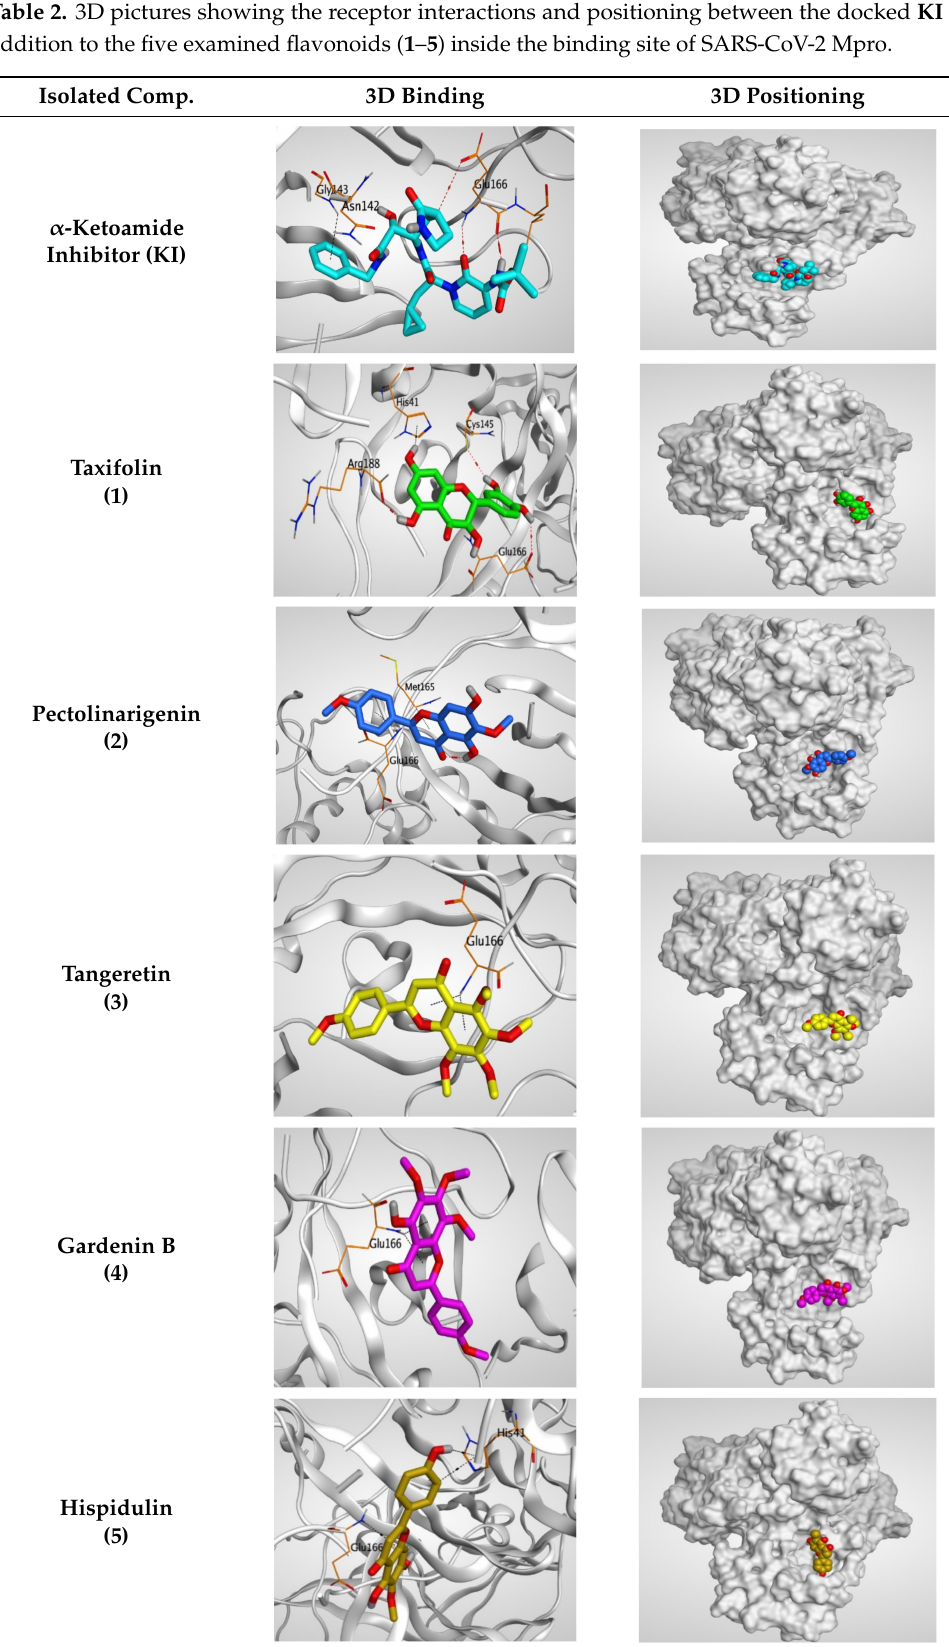
The red dash represents H-bonds and the black dash represents H-pi